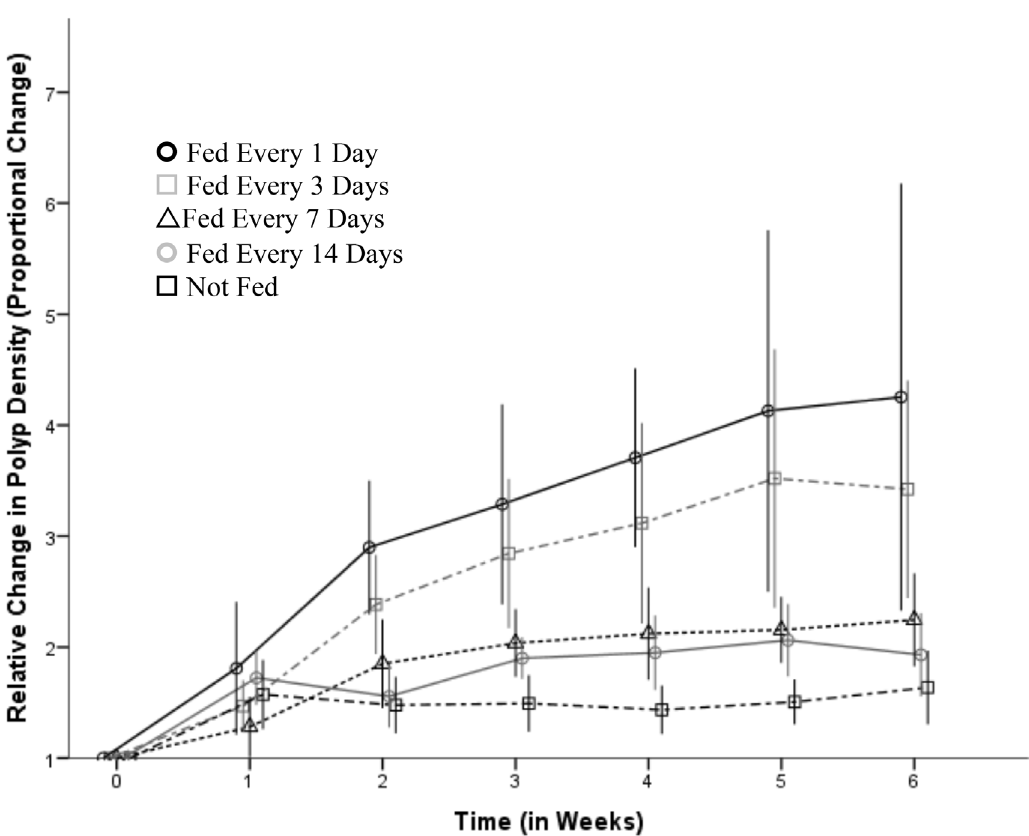
Fig 2. The relative change in Carukia barnesi polyp density, over six weeks of exposure, to five feeding regimes. The feeding levels consisted of: fed every day (dark circles); fed every three days (light squares); fed every seven days (dark triangles); fed every 14 days (light circles); unfed for 42 days (dark squares). Each of the five feeding treatments consisted of six independent replicates, each of which consisted of a mean staring polyp density of 20.5 polyps per well ( n = 30, (cid:1) x = 20.5, SD = 2.8). The values for each time sequence were calculated as the proportional change in polyp density from the starting population density at time zero, where values of one indicate no population change and values above one indicate polyp proliferation through asexual reproduction. Values are reported as means and error bars represent 95% CI assuming a normal distribution. All counts were conducted in seven-day intervals however the values have been graphed offset on the time axis for